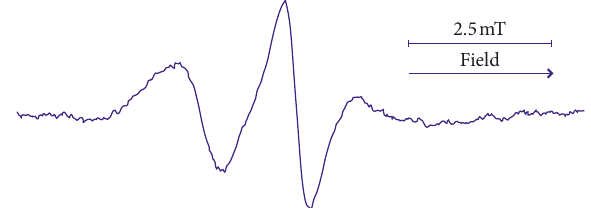
Figure 8: ESR spectrum of spin probe 2 in the erythrocyte sus- pension in the presence of GO suspension (70 μ g/ml).